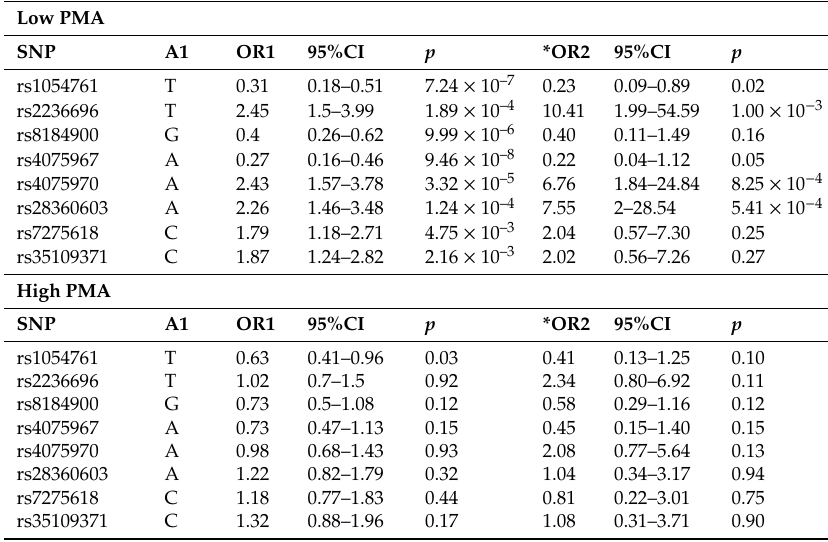
Table 3. Association between PRMD15 SNPs and COPD risk in participants with low and high PMA (proportion of Mapuche ancestry, < 35% vs. ≥ 35%).